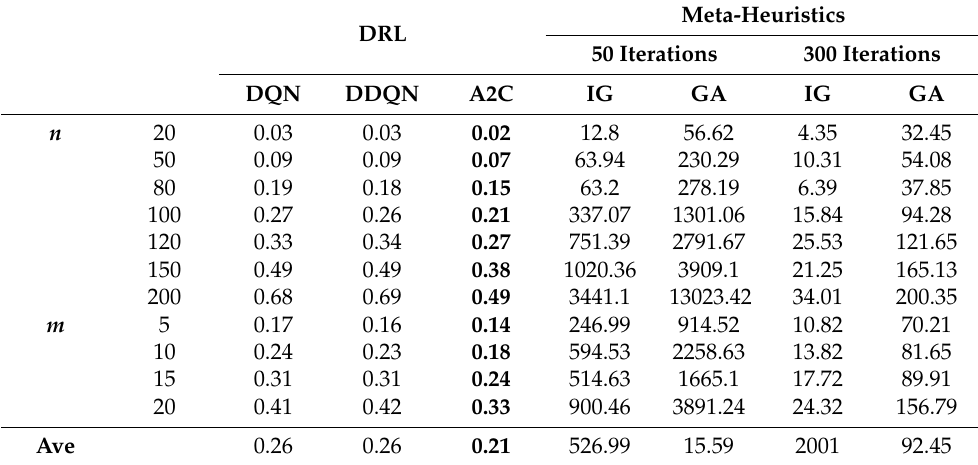
Table 4. Average CPU times (s) grouped by the number of jobs n and machines m for DRL and meta-heuristics. IG and GA are tested under two search iteration levels, i.e., 50 iterations and 300 iterations. The CPU time for an instance is the total CPU time required for solving that instance.